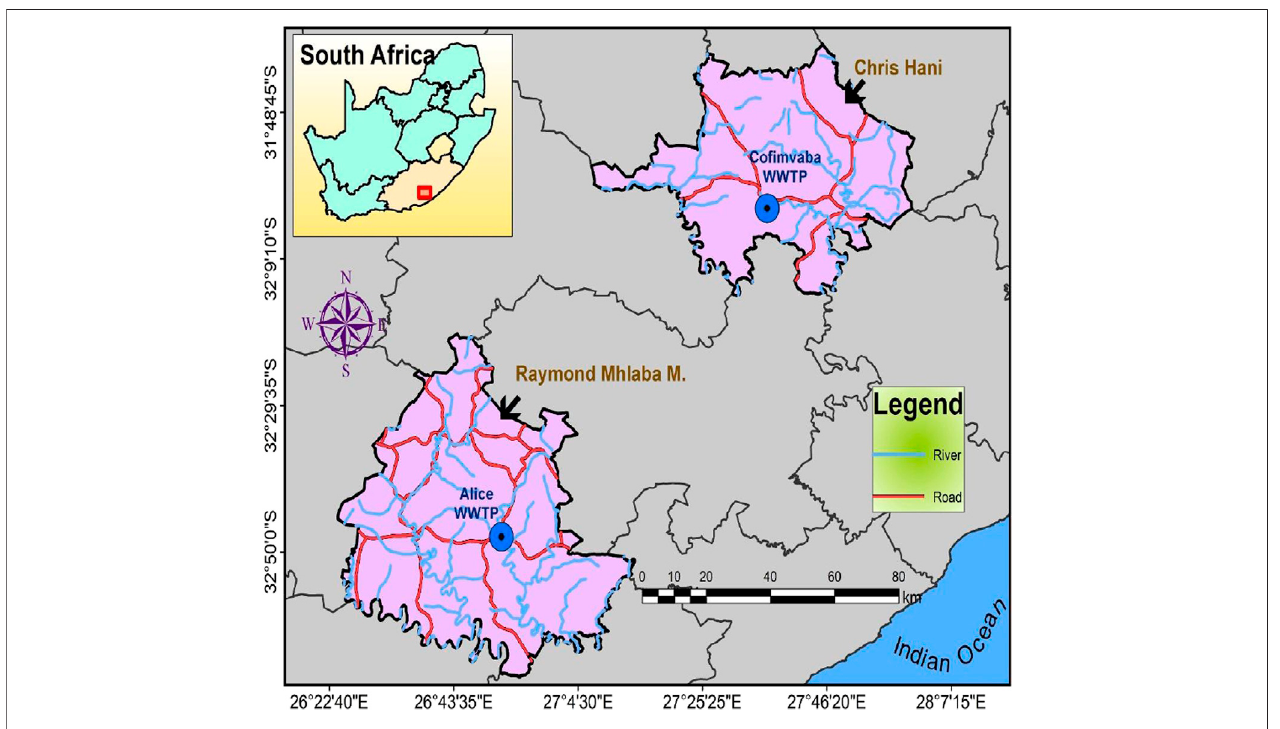
FIGURE 1 | The location of the wastewater treatment